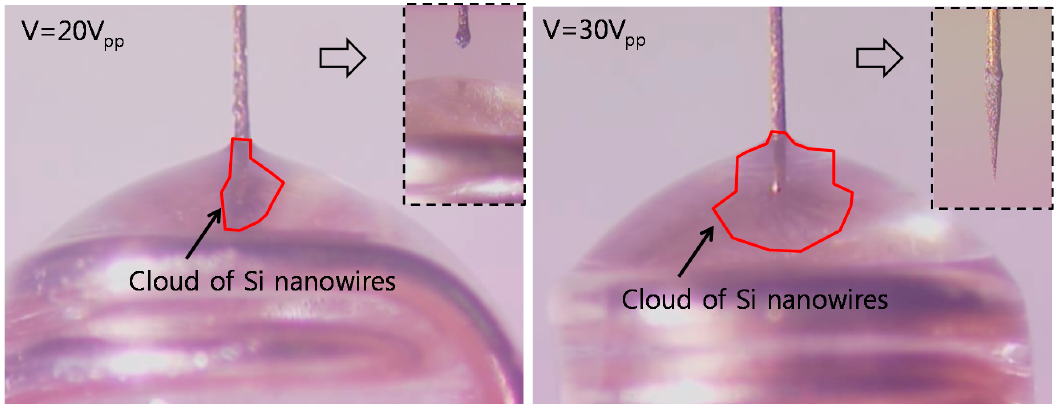
Figure 10. Comparison of nanotip fabrication: 20 V pp ( left ); and 30 V pp ( right ). The Si nanowire clouds, attracted by the voltages, are expressed by the red lines. The inset shows the fabricated nanotips after withdrawal.